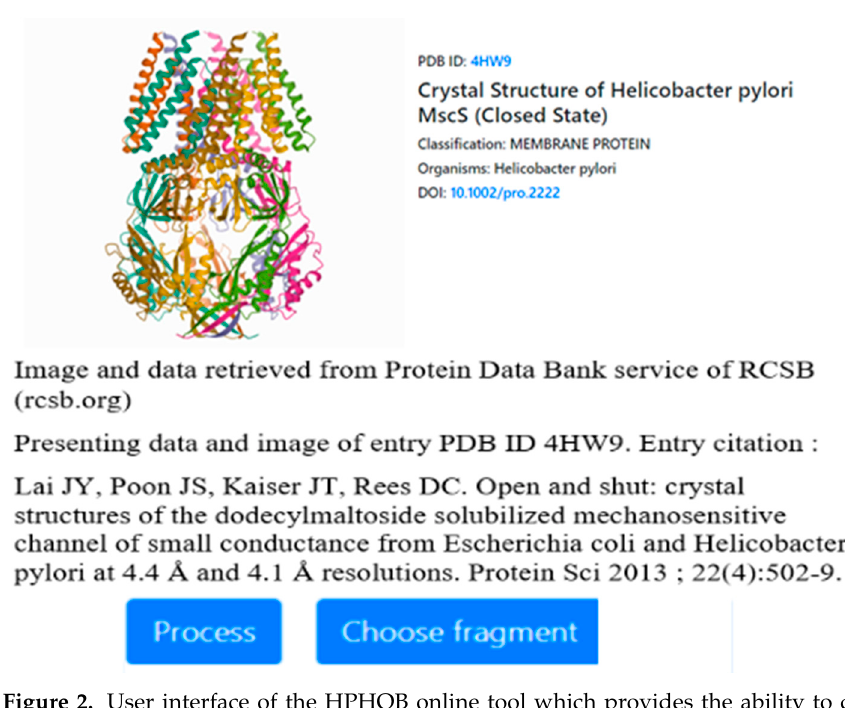
Figure 2. User interface of the HPHOB online tool which provides the ability to compute FOD model parameters for arbitrary protein structures. The tool is available at https://hphob.sano.science (accessed on 15 December 2021).